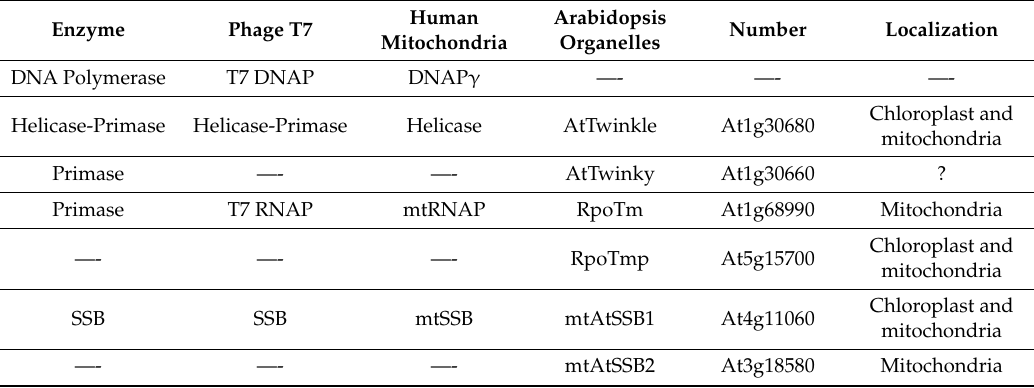
Table 1. Proteins related to bacteriophage T7 proteins present in plant